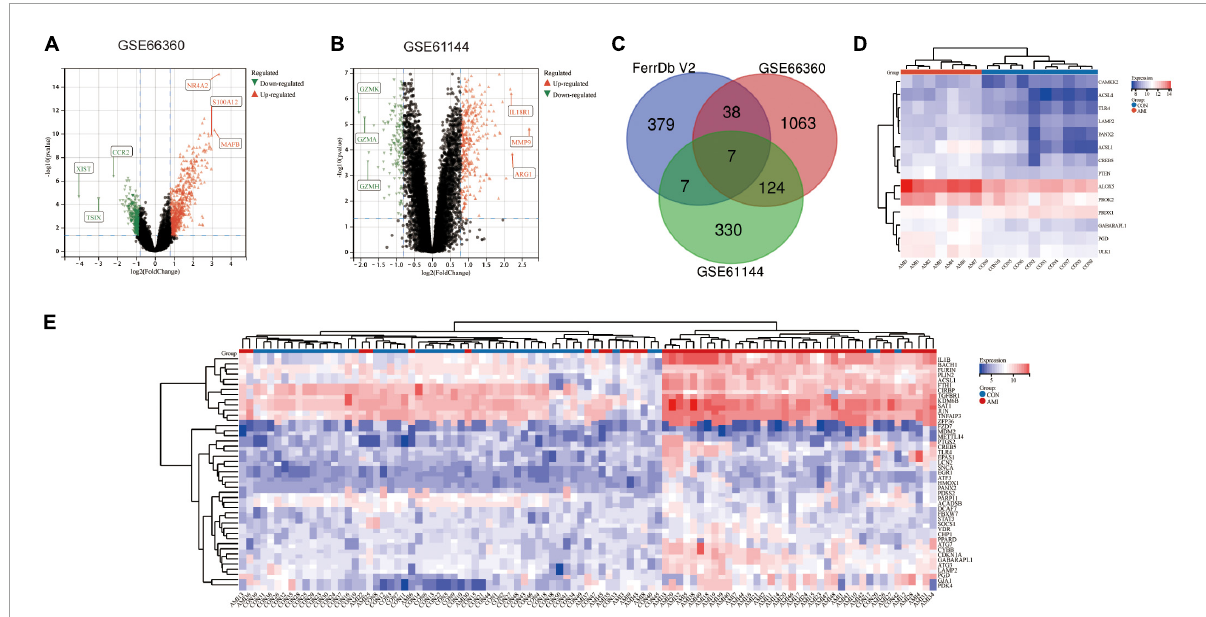
FIGURE2 Identification of differentially expressed FRGs in GSE66360 and GSE61144. (A) The volcano plot of GSE66360. (B) The volcano plot of GSE61144. (C) Venn diagram of DEGs in GSE66360, GSE61144, and FRGs in FerrDb. (D) Heatmap of FRGs in GSE66360. (E) Heatmap of FRGs in